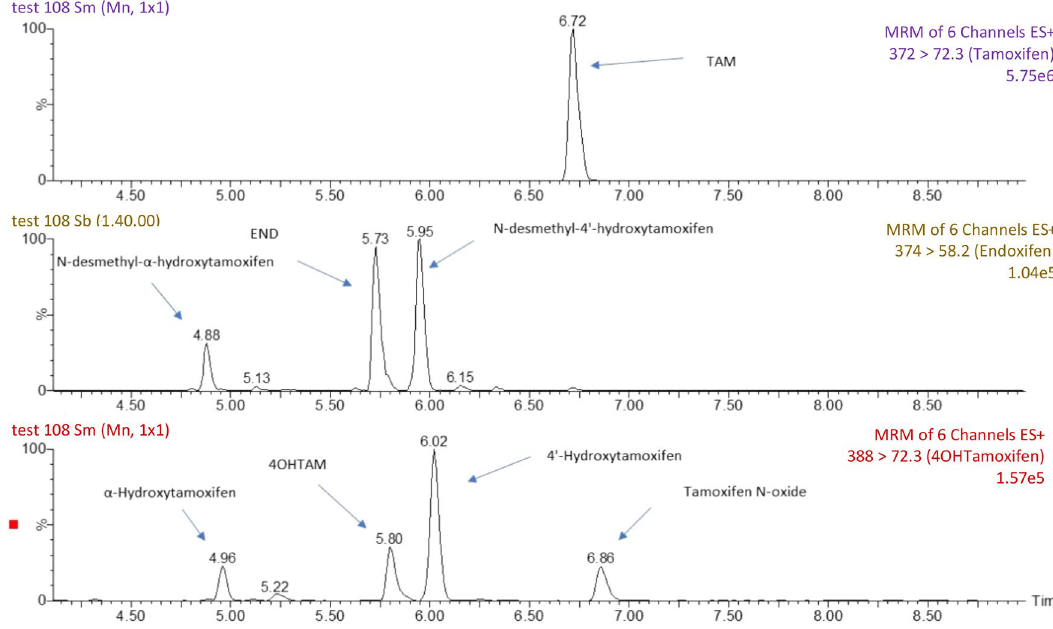
Figure 4. Mass spectrometry results demonstrating fragmentation pathways for tamoxifen (TAM), Z-endoxifen (END), and 4-hydroxytamoxifen (4HT), respectively. The graphs show the separate peaks for each analyte and demonstrate that there is no overlap between the peaks of these analytes or of any other TAM